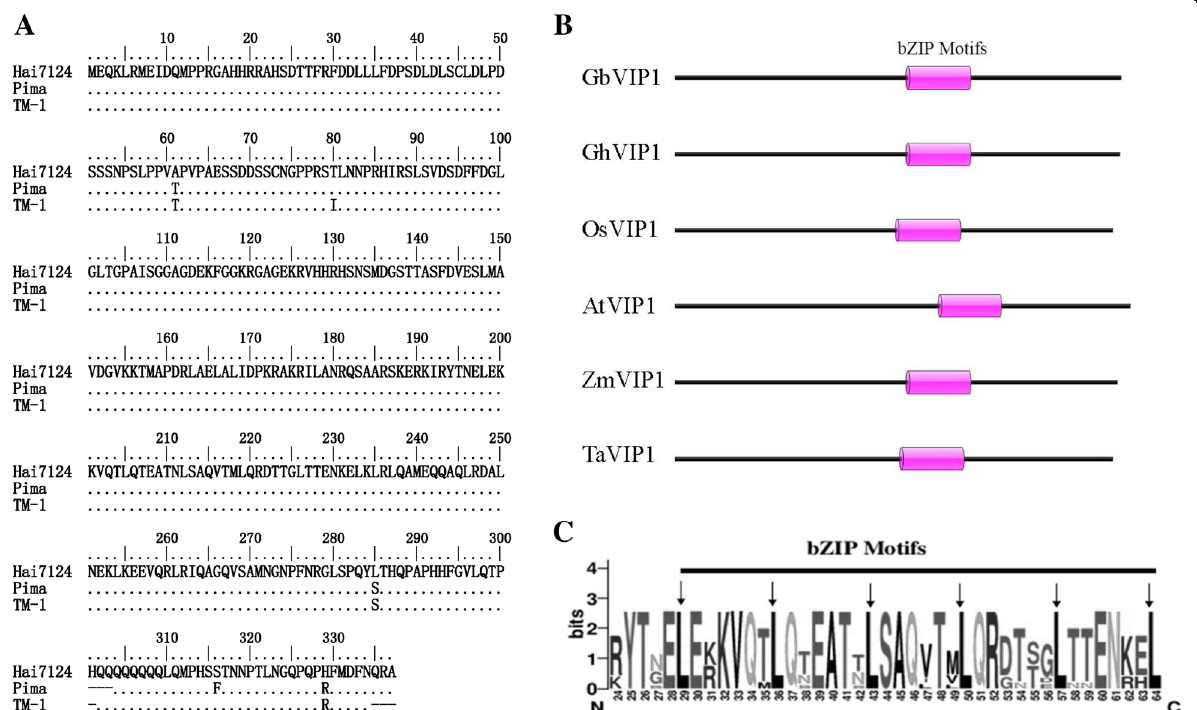
Fig. 1 The VIP1 protein sequences from three cotton cultivars and analysis of bZIP domain in VIP proteins. a Amino acid differences among VIP1 protein sequences from cvs TM-1, Hai 7124 and Pima. b structural analysis of VIP1 proteins from different plant species. c Sequence logos showing the highly conserved bZIP domain: one leucine every six amino